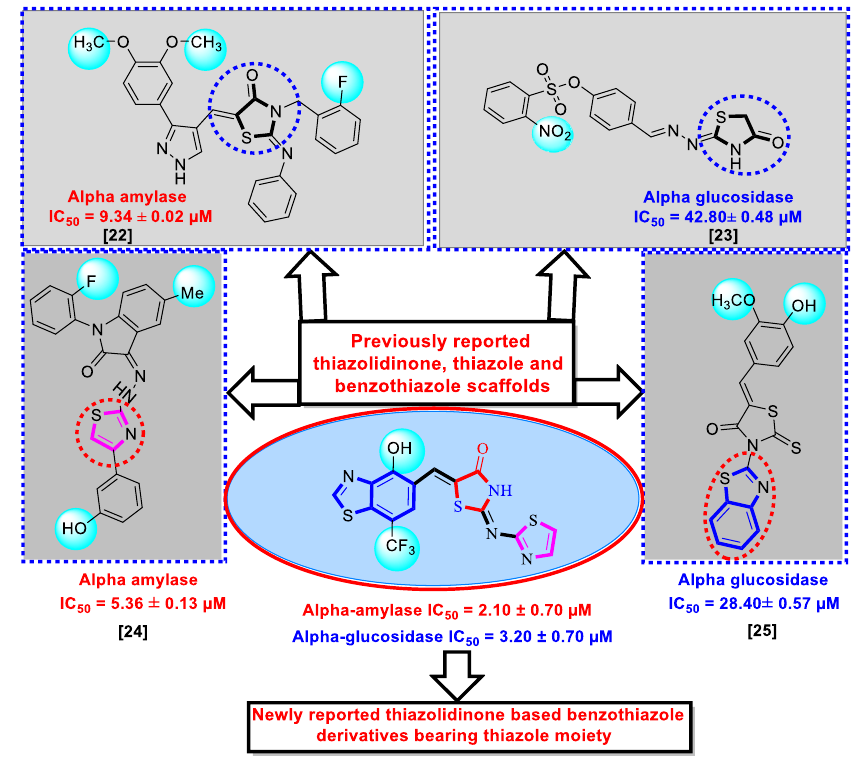
Figure 1. Rational of the current study, refs